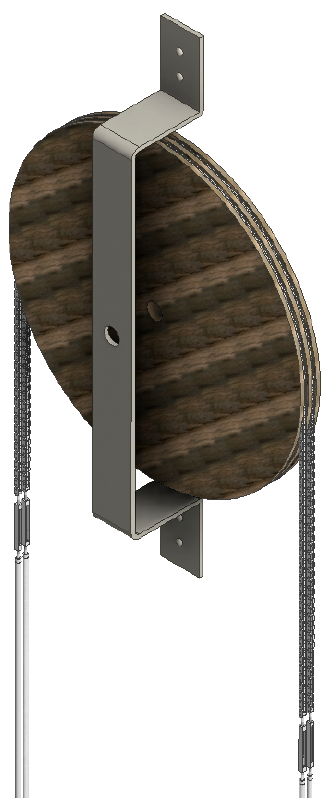
Figure 11. Detail of the upper wheel transmission.